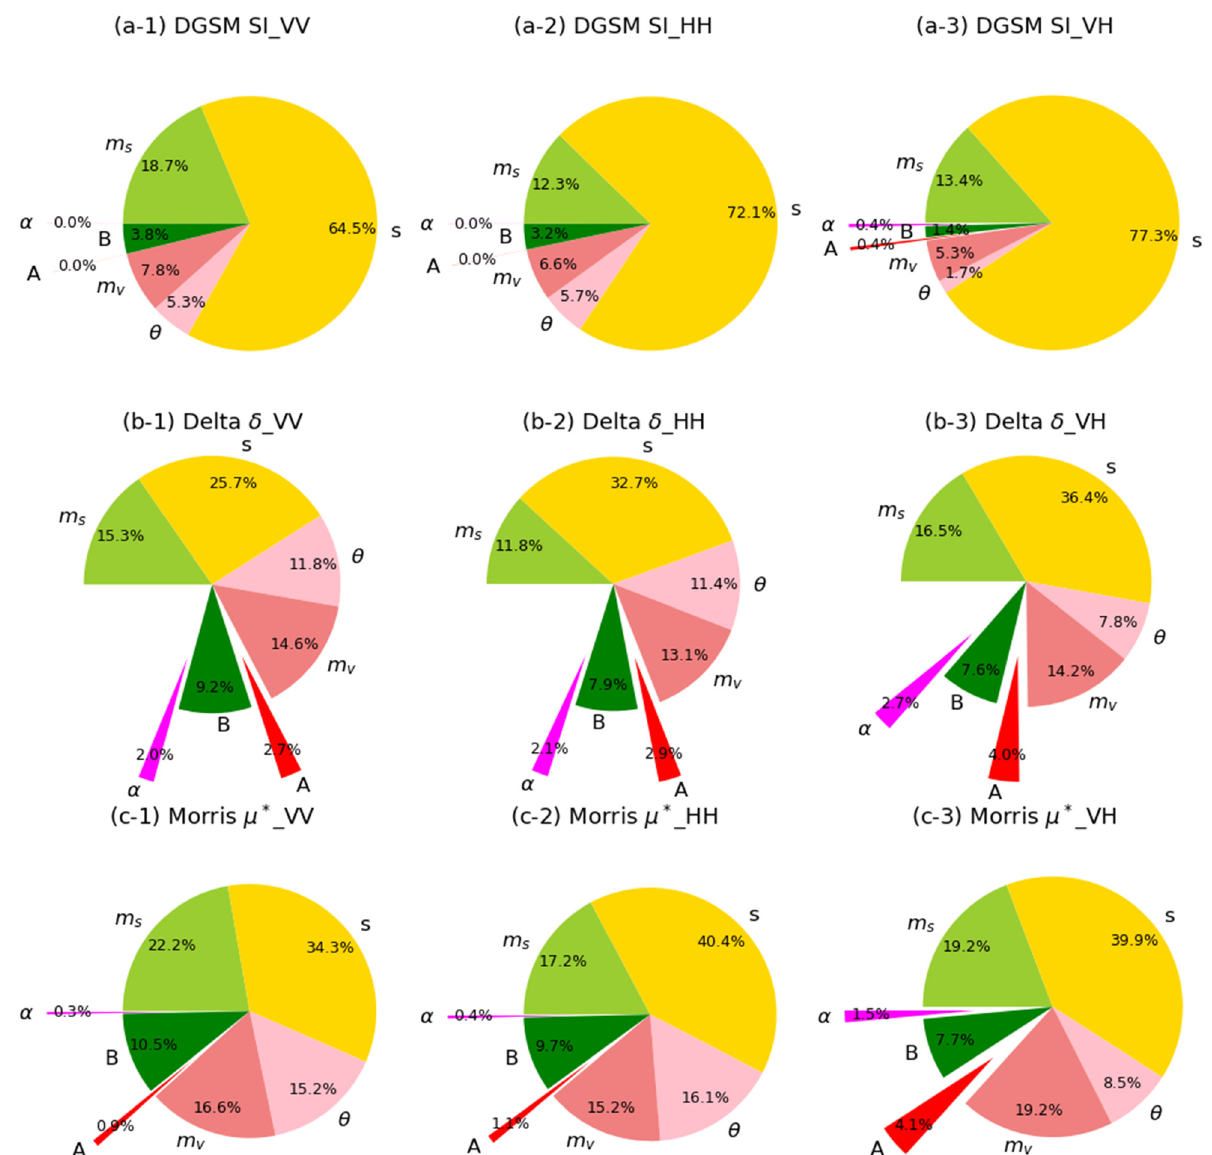
Figure 3. Parameter SIs from the three qualitative methods (DGSM, Delta test, and Morris) under Bindlish vegetation description scheme. The SIs are represented by SI, δ , and μ *, respectively.